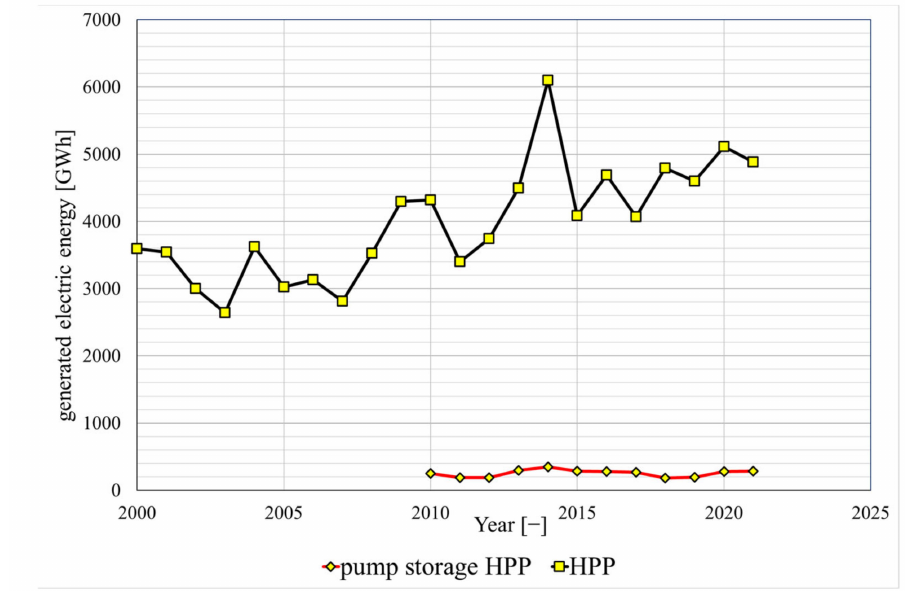
Figure 2. Electricity generation in HPPs in Slovenia per year since